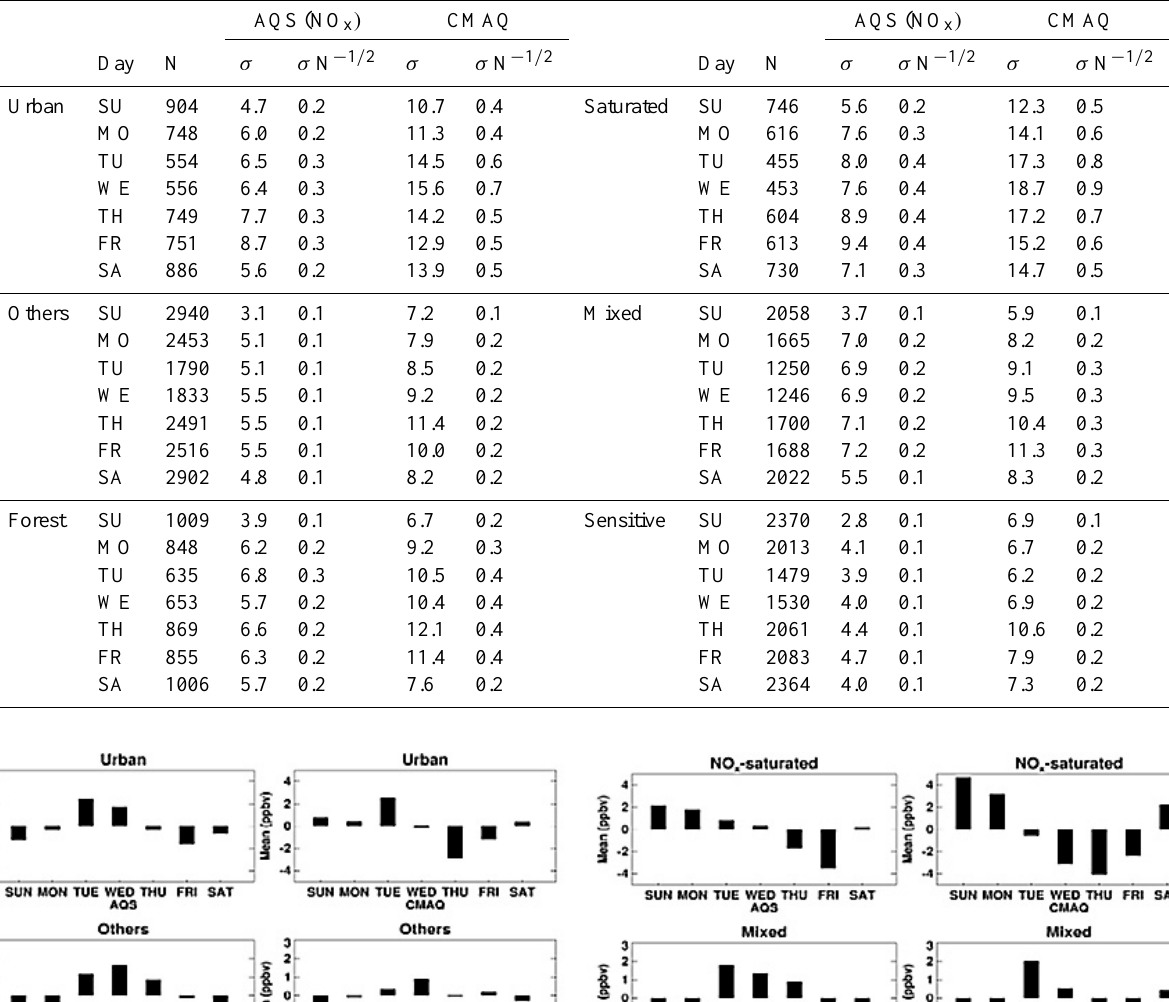
Table 2. The number of data (weekly anomaly), the standard deviation, and the standard error of the mean (SEM) of EPA AQS observations and CMAQ simulations for NO x measurement sites over the AVHRR-derived geographical regions and the GOME-2-derived chemical regimes.